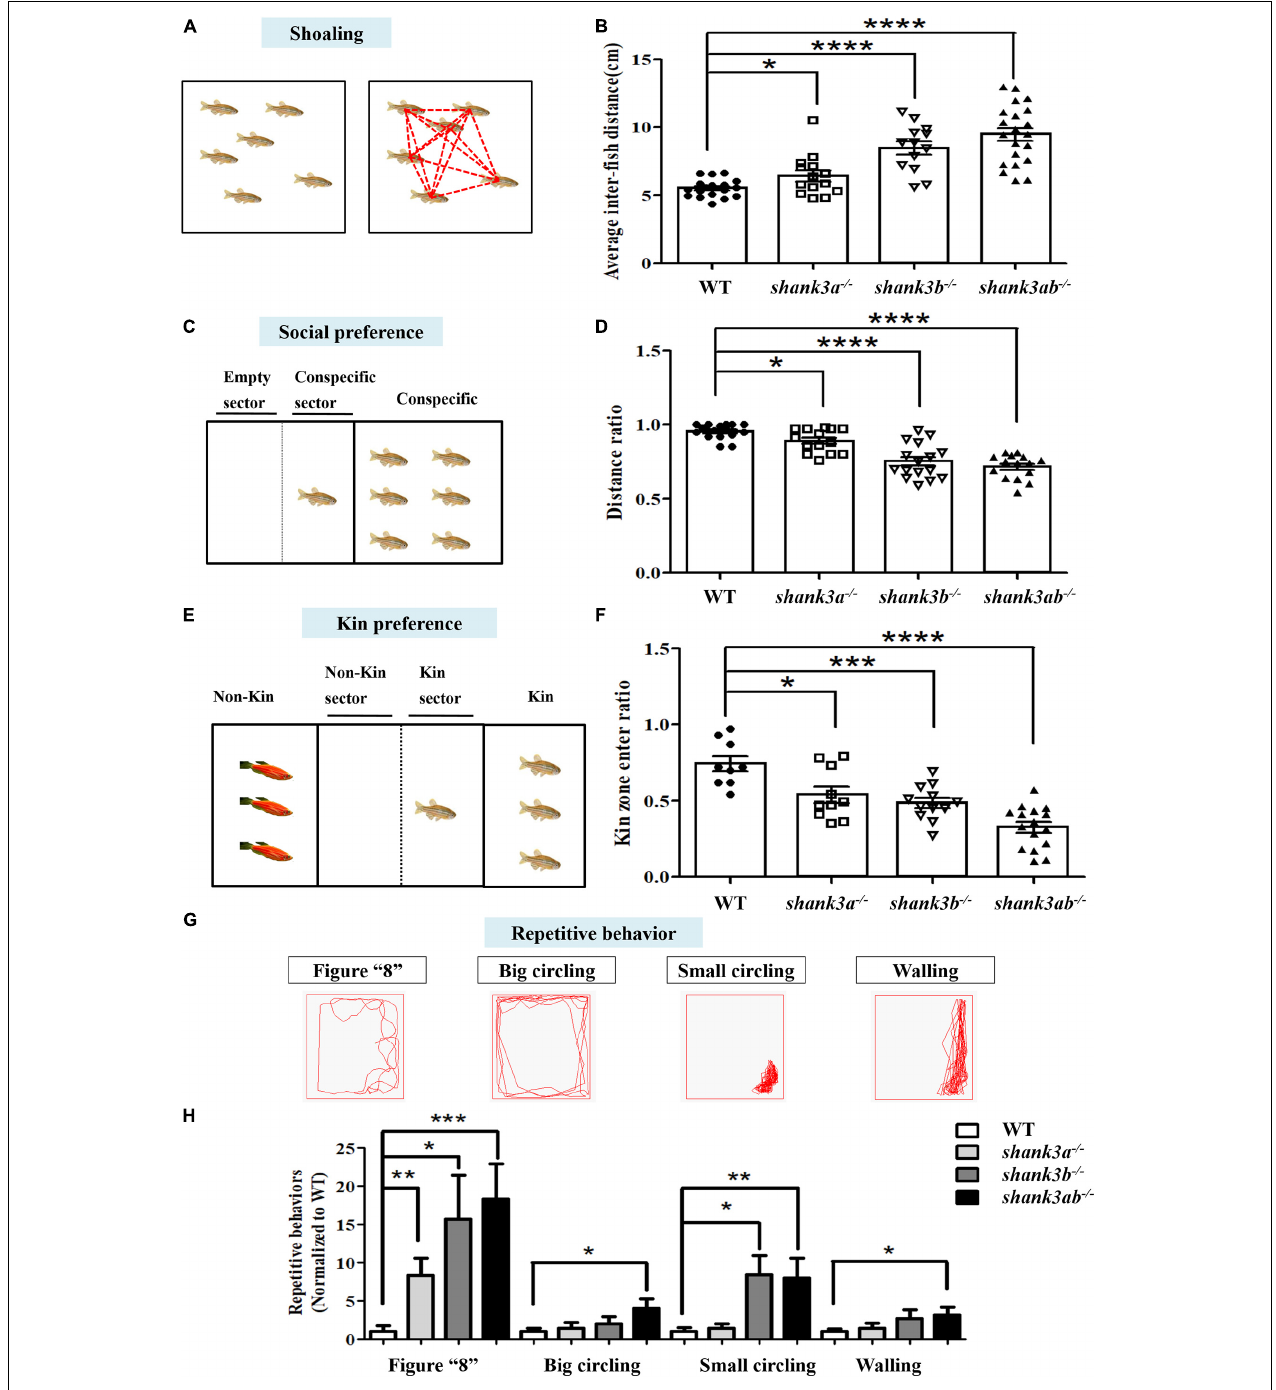
FIGURE 3 | Core behavioral features of ASD-like displayed in shank3 -deficient zebrafish. (A,B) The shoaling test showed significantly increased average inter-fish distance of adult male shank3 -deficient zebrafish (3.5 mpf). WT, N = 18; shank3a - / - , N = 14; shank3b - / - , N = 13; shank3ab - / - zebrafish, N = 21. (C,D) The social preference test showed distance ratio in the conspecific sector were significantly reduced in shank3 -deficient zebrafish compared to WT adult male zebrafish (3.5 mpf). WT, N = 16; shank3a - / - , N = 14; shank3b - / - , N = 16; shank3ab - / - zebrafish, N = 15. (E,F) The Kin recognition and preference test showed significantly reduced ratio of Kin zone entering in shank3 -deficient zebrafish compared to WT adult male zebrafish (3.5 mpf). WT, N = 9; shank3a - / - , N = 10; shank3b - / - , N = 12; shank3ab - / - zebrafish, N = 16. (G) Representative trace of different types of stereotyped behaviors of shank3 -deficient adult male zebrafish (3.5 mpf). (H) shank3 -deficient zebrafish had a significantly higher proportion of stereotyped movements than WT zebrafish. WT, N = 12; shank3a - / - , N = 14; shank3b - / - , N = 14; shank3ab - / - zebrafish, N = 16. Data are presented as mean ± SEM; * P < 0.05, ** P < 0.01, *** P < 0.001, **** P < 0.0001.